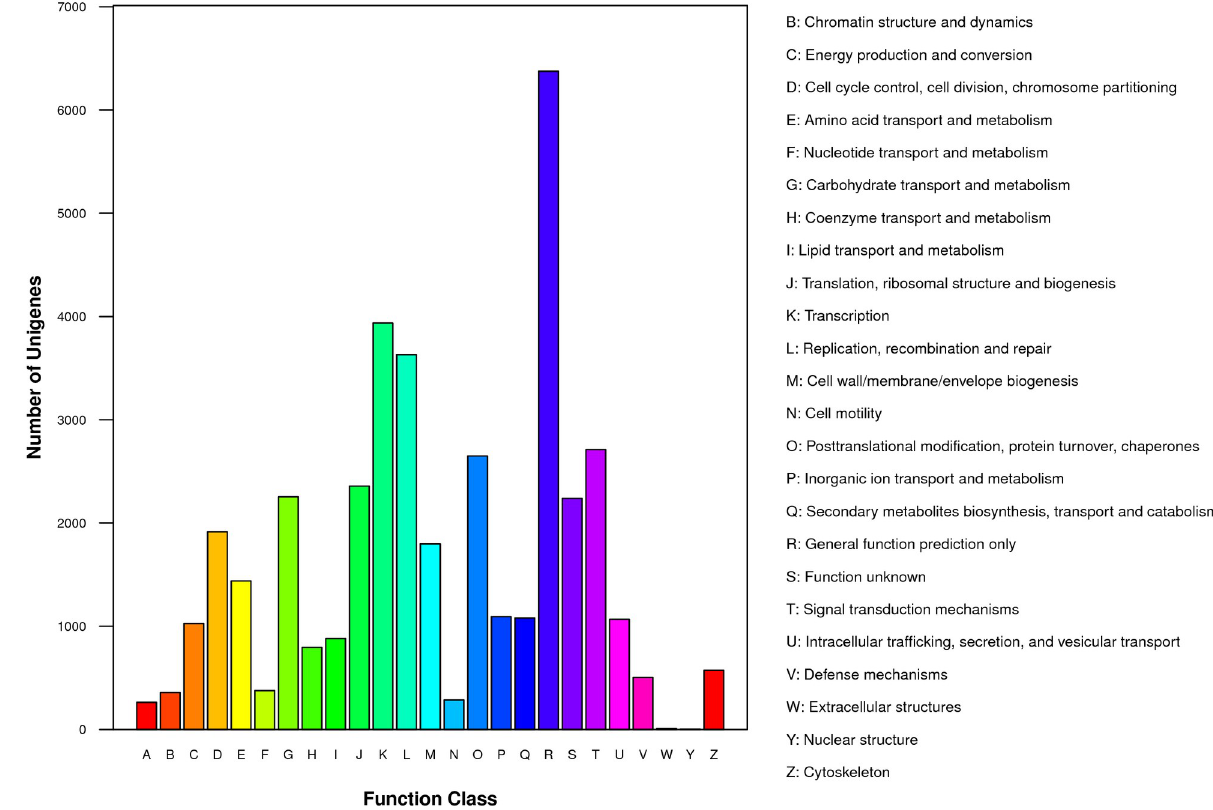
Fig 1. COG function classification by BLASTx with an E value threshold of 10 − 5 against COG databases.